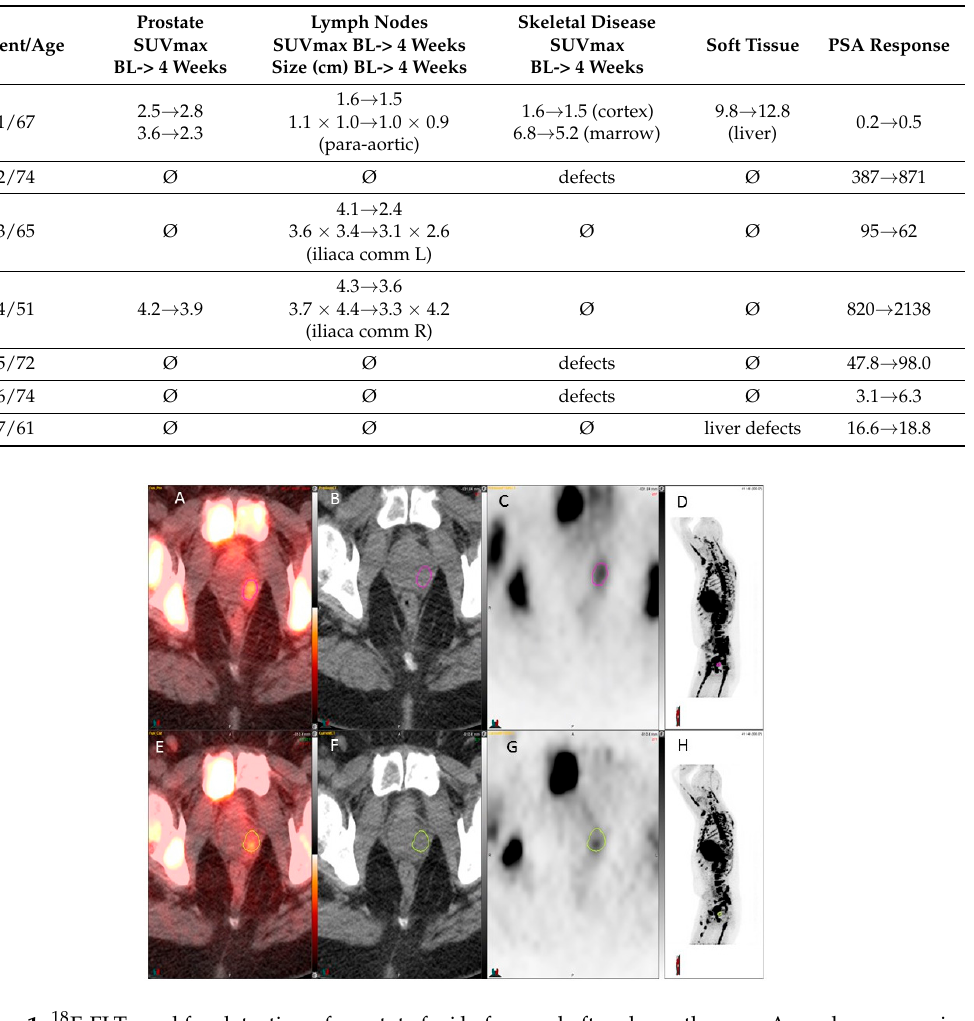
Figure 1. 18 F-FLT used for detection of prostate foci before and after chemotherapy. A weak response is seen, while the SUVmax value decreased from 3.6 to 2.3 in the left prostate lobe (circles in C and G ). Upper row, baseline: from the left fusion image ( A ), computerized tomography (CT) image ( B ), fluorine-18 fluorothymidine with positron emission tomography ( 18 F-FLT PET) image ( C ); and maximum intensity projection (MIP) image ( D ); lower row, after 4 weeks of therapy: from the left fusion image ( E ), CT image ( F ), 18 F-FLT PET image ( G ), and MIP image ( H ). Color bar range from 0 to 5.